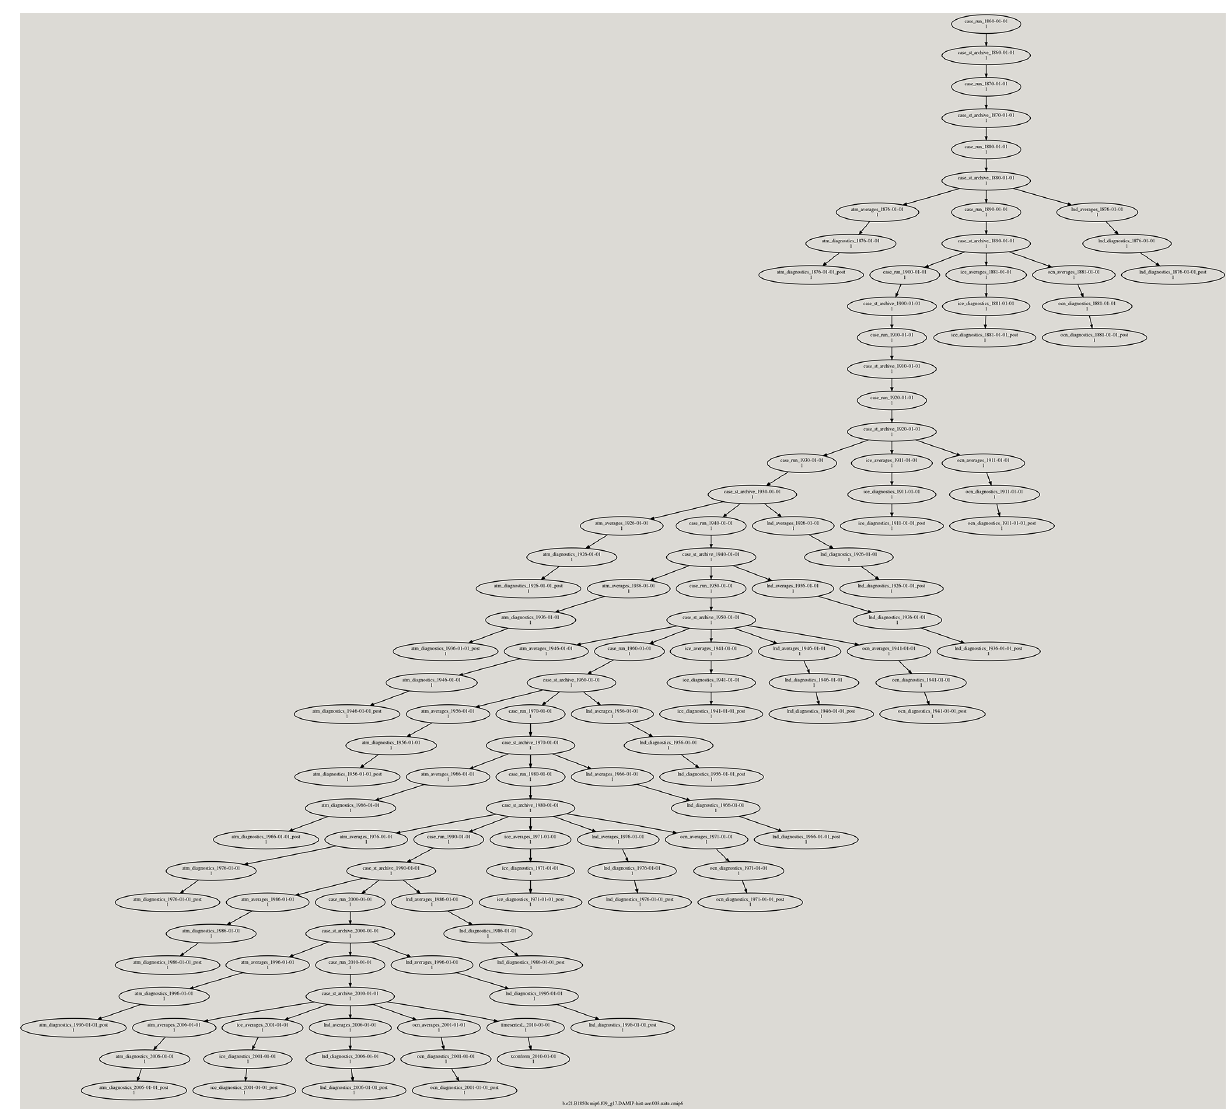
Figure A1. This figure shows a Cylc dependency workflow graph that was generated for an experiment we ran for CMIP6 which required us to simulate the climate from 1850 to 2015. The CESM model and its data movement utility were run within this workflow. The CESM component diagnostic packages were also run within this workflow. The ocean and ice model diagnostics were run after every 30 years of simulation, and the atmosphere and land model diagnostics were run after every 10 years of simulation. The different diagnostic packages were run as part of the many three-chained tasks that are leaves within the workflow graph. The first task runs the PyAverager to generate the climatologies. The second task runs the NCL scripts in parallel to generate the plots and the web pages they are displayed on. The third task is a post-command that copies the image and web files onto the web server. The PyReshaper and the PyConform tools were run at the end of the